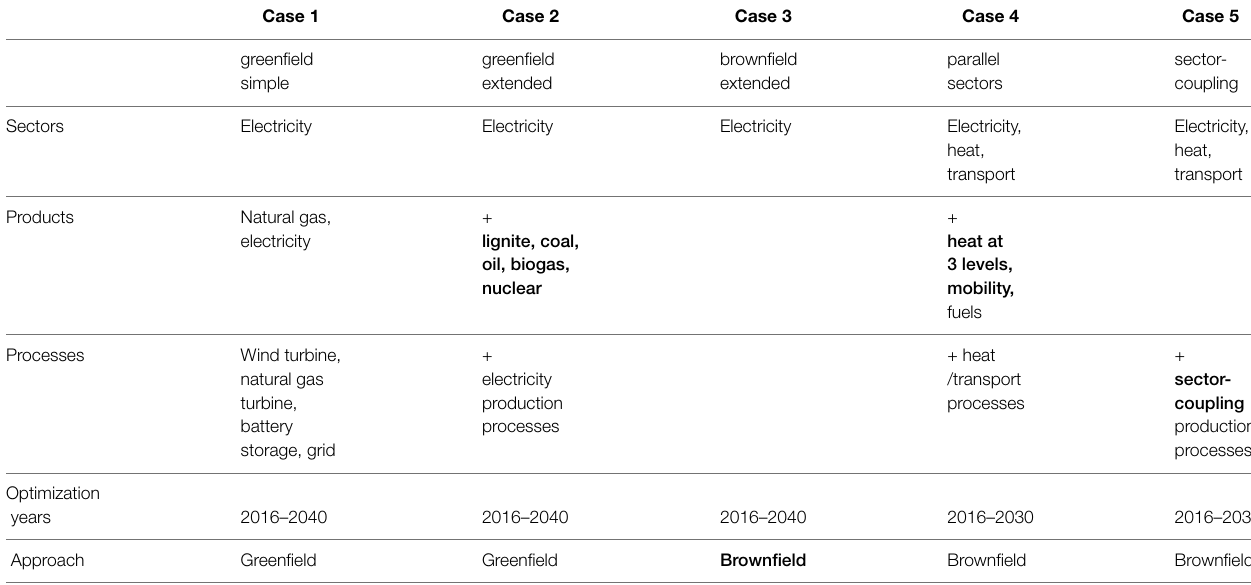
TABLE 3 | List of case studies considered to demonstrate the modular setup of SecMOD. All cases built up on the previous cases. Extensions of previous case settings are indicated by a ‘+’. For each case study, we highlighted the most important extension, compared to the respective previous case, in